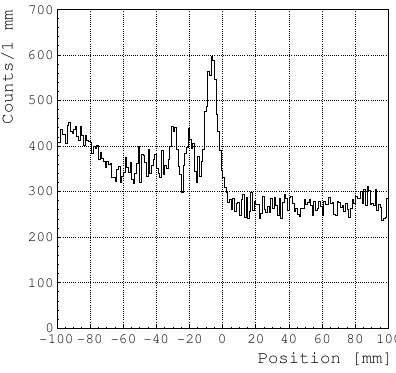
Fig. 5. Measured acceptance-corrected position spectrum with a condition of the reaction angle < 15 mrad.